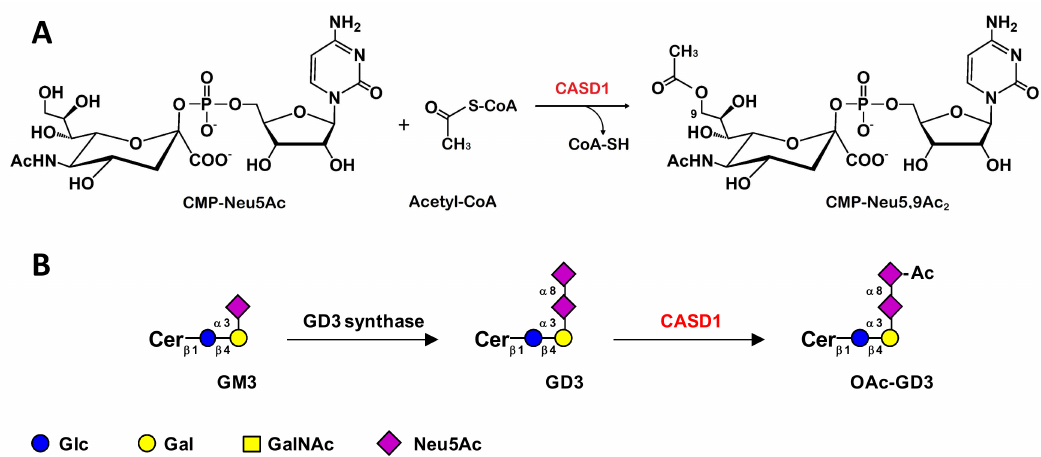
Figure 2. Proposed CASD1 O -acetyltransferase activity. ( A ) CAS1 Domain-Containing Protein 1 (CASD1) sialyl- O -acetyltransferases (SOAT) activity on CMP-Neu5Ac. ( B ) Biosynthesis pathway for OAcGD3 ganglioside by direct acetylation of GD3. Cer: